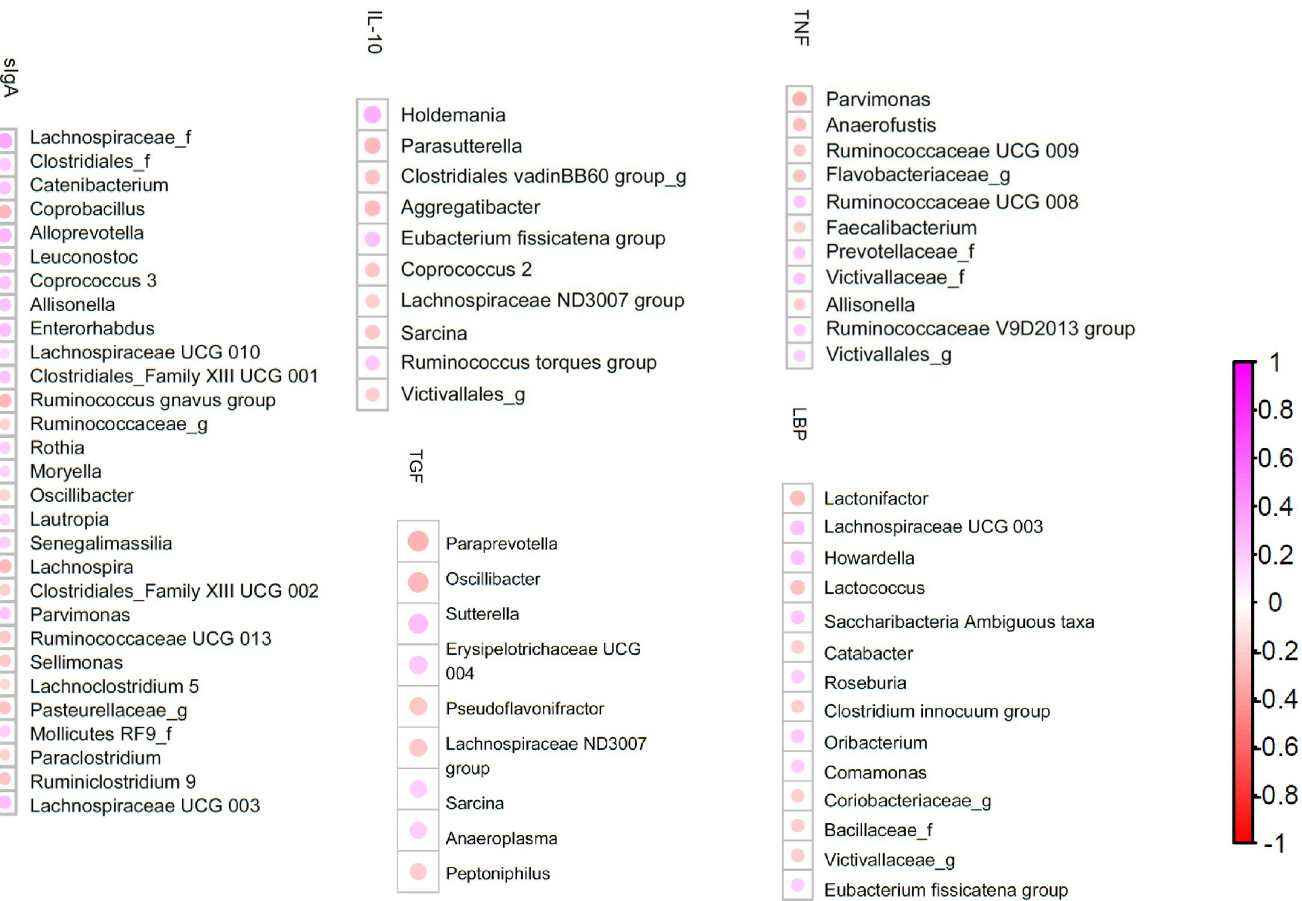
Fig 2. Spearman correlation between immune parameters and gut microbiota composition. Only taxa that are significant (q < 0.2) are shown, ranked from highest q to lowest q . Purple: Positive Spearman correlation factor (rho); red: Negative rho.